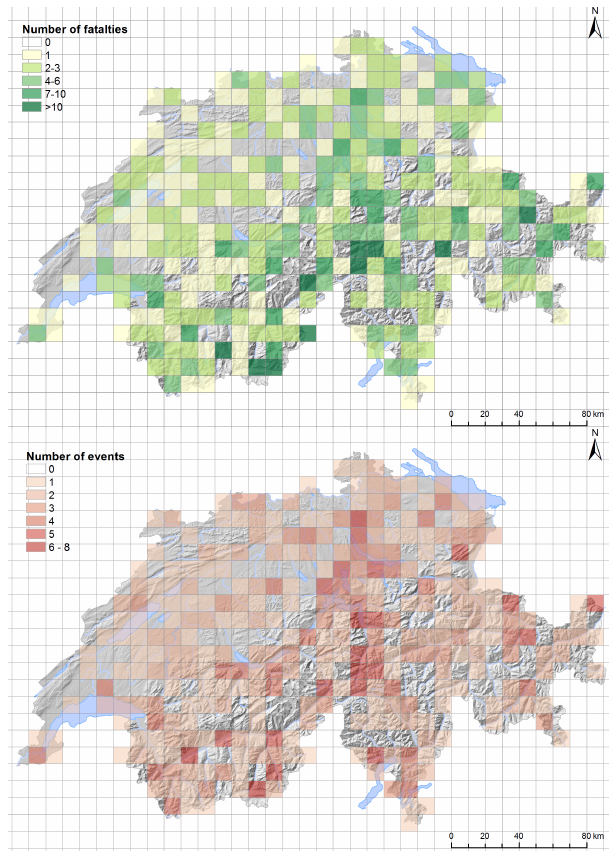
Figure 9. Spatial distribution of natural hazard fatalities (above) and fatal natural hazard events (below) in Switzerland over the 70-year study period using a 10 × 10km raster grid (DHM source: dhm25 © 2016 swisstopo, 5704 000 000).